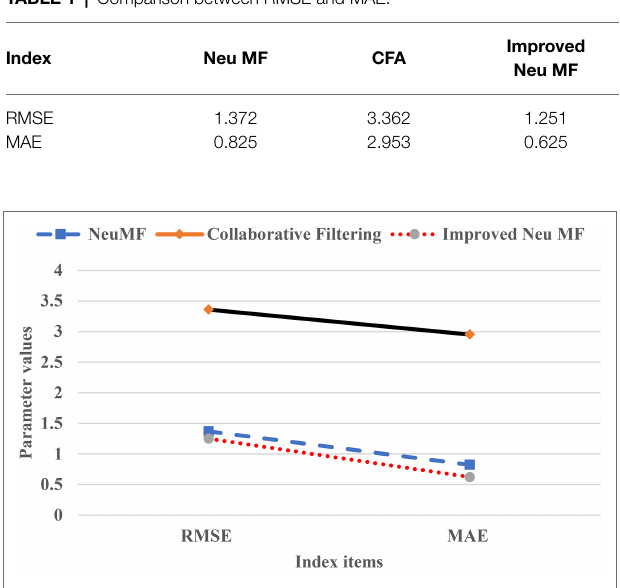
TABLE 1 | Comparison between RMSE and MAE.